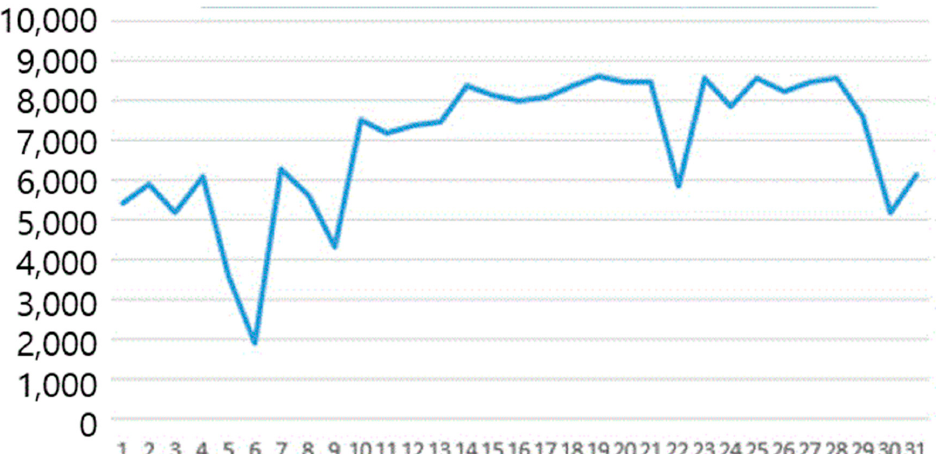
Figure 10. Yeongam Photovoltaic Power Plant Power generation in July 2018.